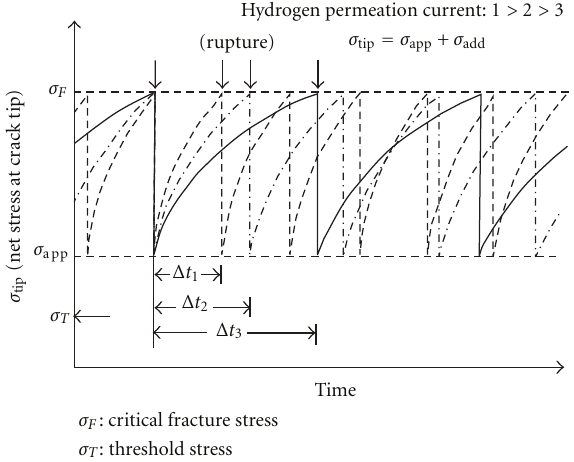
Figure 8: Schematic representation of time dependence of the net local stress ( σ tip ) during the film rupture-formation events at various hydrogen permeation currents under a constant applied stress condition, where σ T is the threshold stress below which no HE takes place and σ F is the critical fracture stress at or above which the failure of α (cid:2) -martensite occurs.